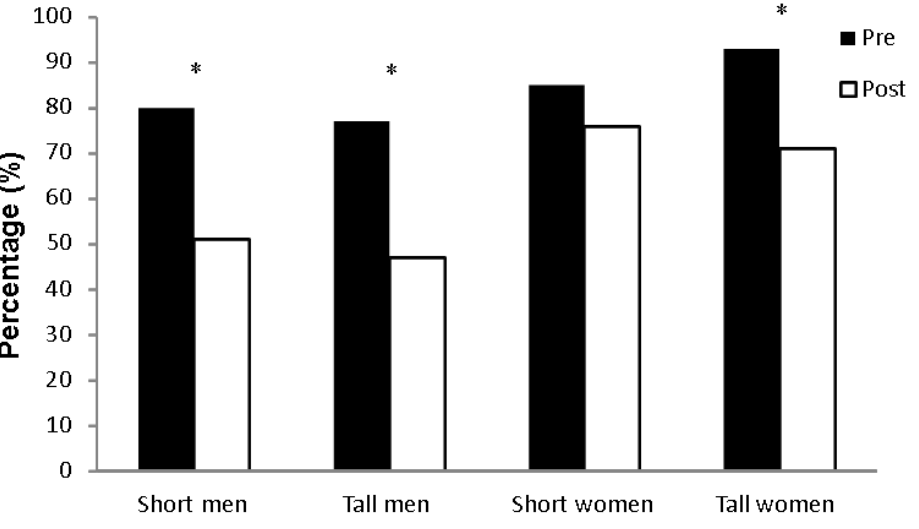
Figur 3. Verbal approach to an aggressive man by short (N = 44) and tall (N = 39) men, short (N = 26) and tall (N = 27) women at pre test and post test. * Indicates significantly different from pre test to post test at 0.05